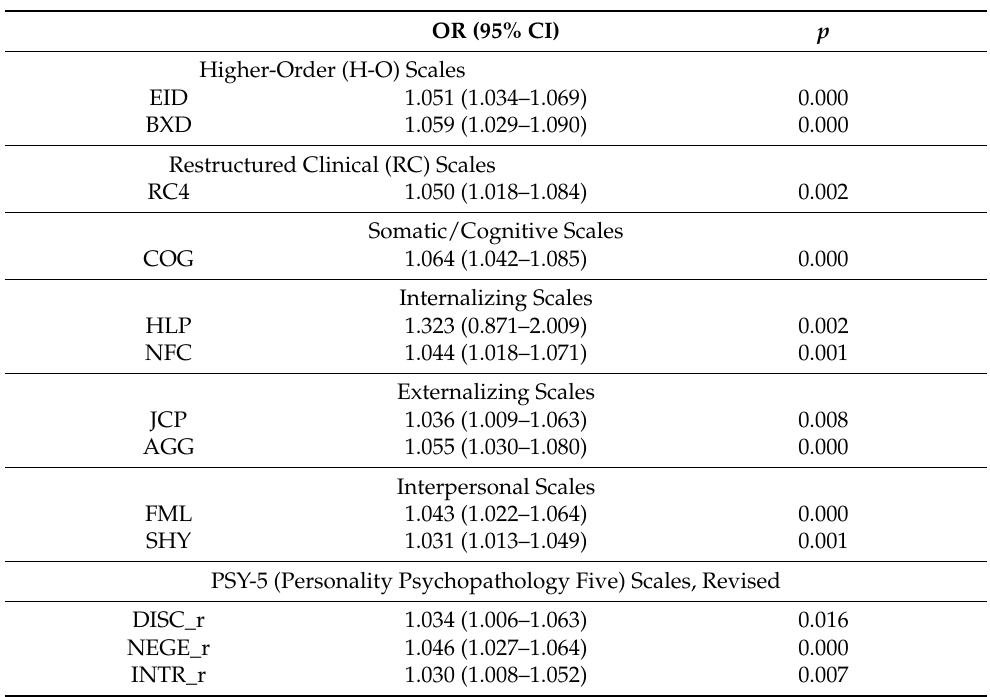
Table 4. Association between smartphone overdependence and MMPI-2-RF scales assessed by logistic regression